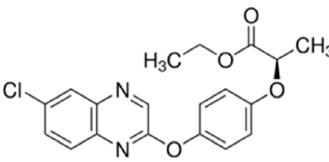
Figure 1. Structure of quizalofop-p-ethyl. Molecular mass: 372.8 g/mol.